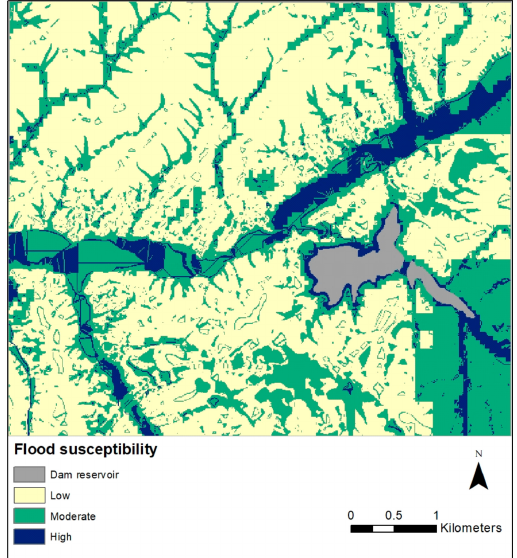
Figure 12. Flood susceptibility map of the study area (modified after Reference